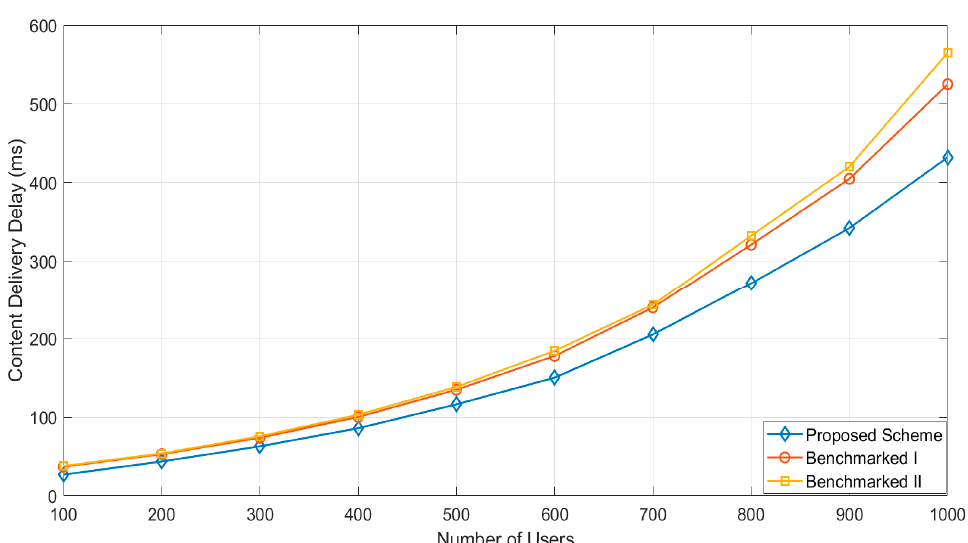
Figure 13. Content delivery delay V/S number of users.